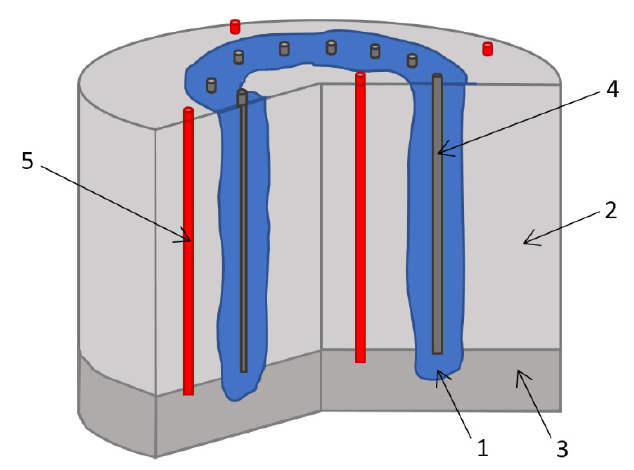
Figure 1. Vertical section of soils during AGF: 1—frozen wall, 2—unfrozen wet soil, 3—waterproof layer, 4—freeze pipe, 5—TM well.